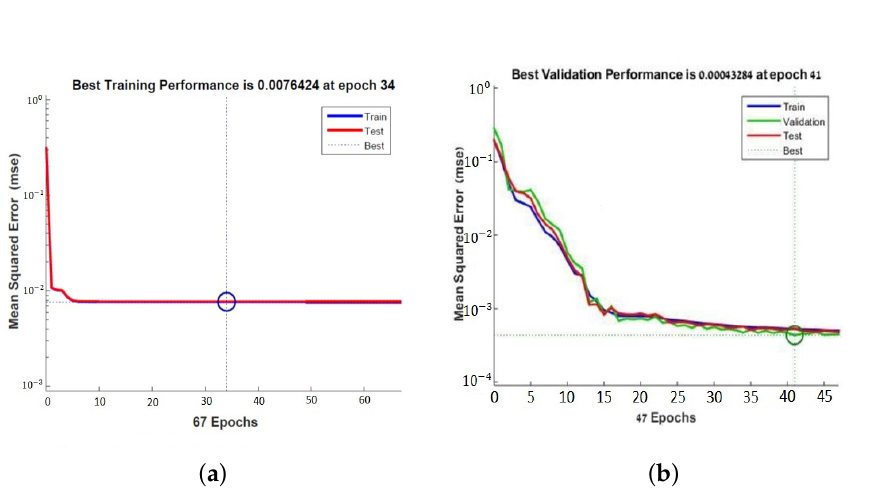
Figure 7. Learning curves of the neural network for PFA antenna ( a ) and for tuned antenna ( b